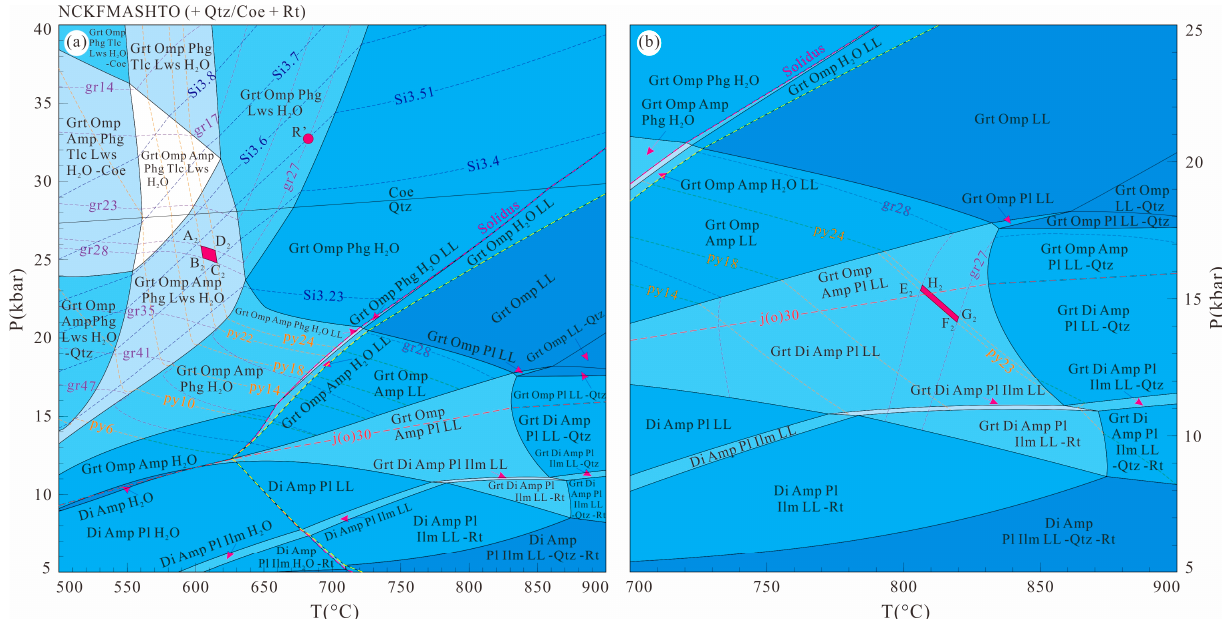
10 of 28 Figure 7. ( a ) P-T pseudosection for sample G-10 calculated with the bulk-rock composition. ( b ) P-T pseudosection for sample G-10 calculated with an effective bulk composition generated according